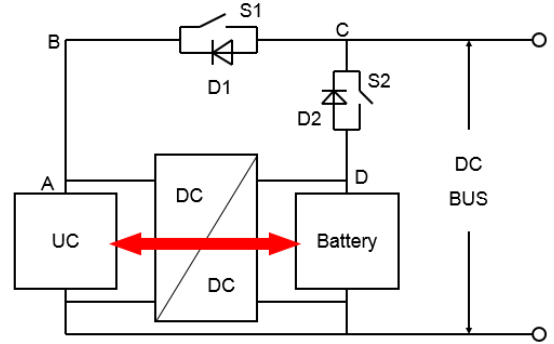
Figure 7. Energy flow in Mode